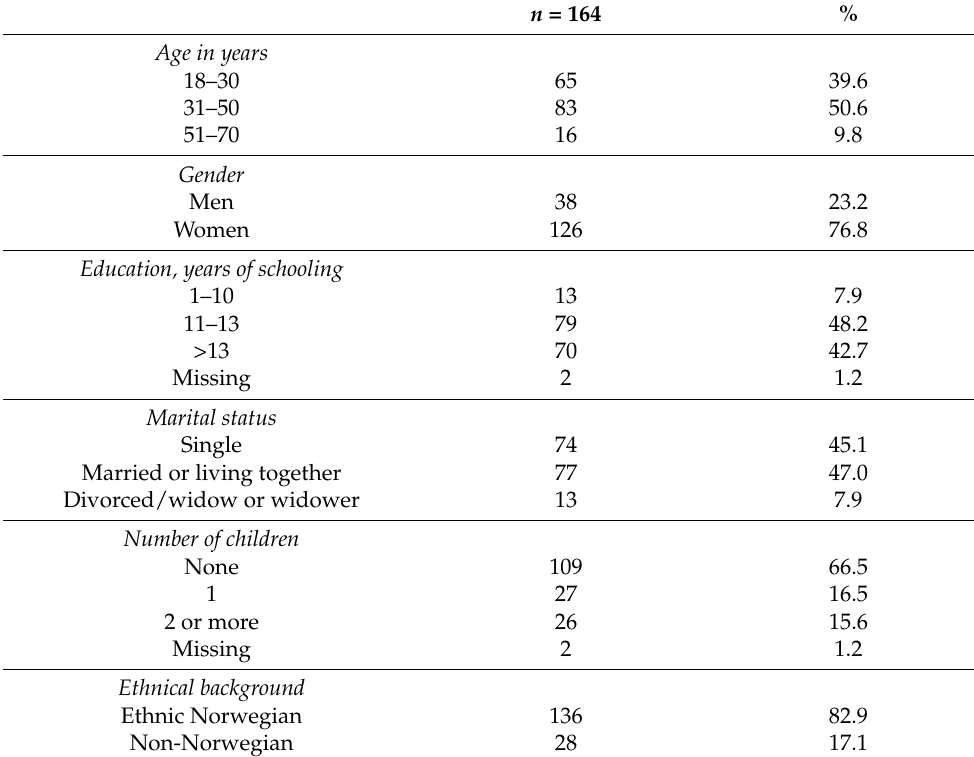
Table 1. Socio-demographic characteristics of 164 patients attending Community Mental Health Centers in the Oslo Metropolitan area during the COVID-19